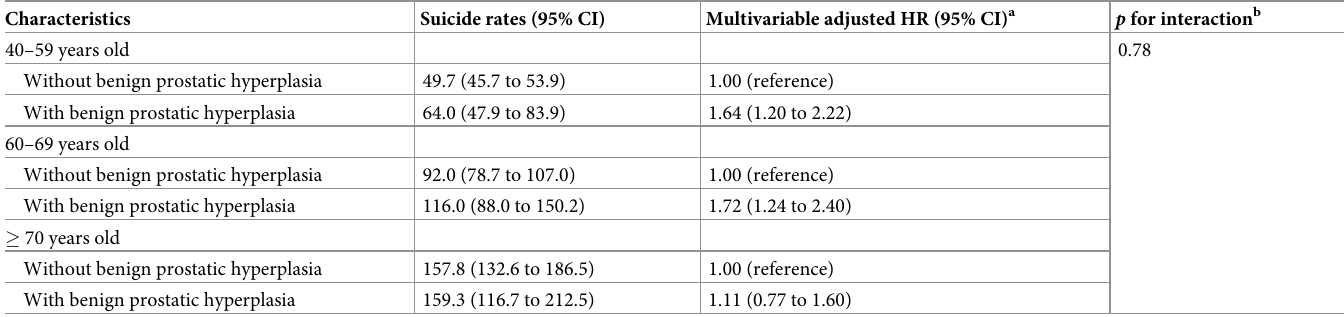
Table 4. Hazard ratios (95% CI) for suicide among patients with benign prostatic hyperplasia according to different age groups.